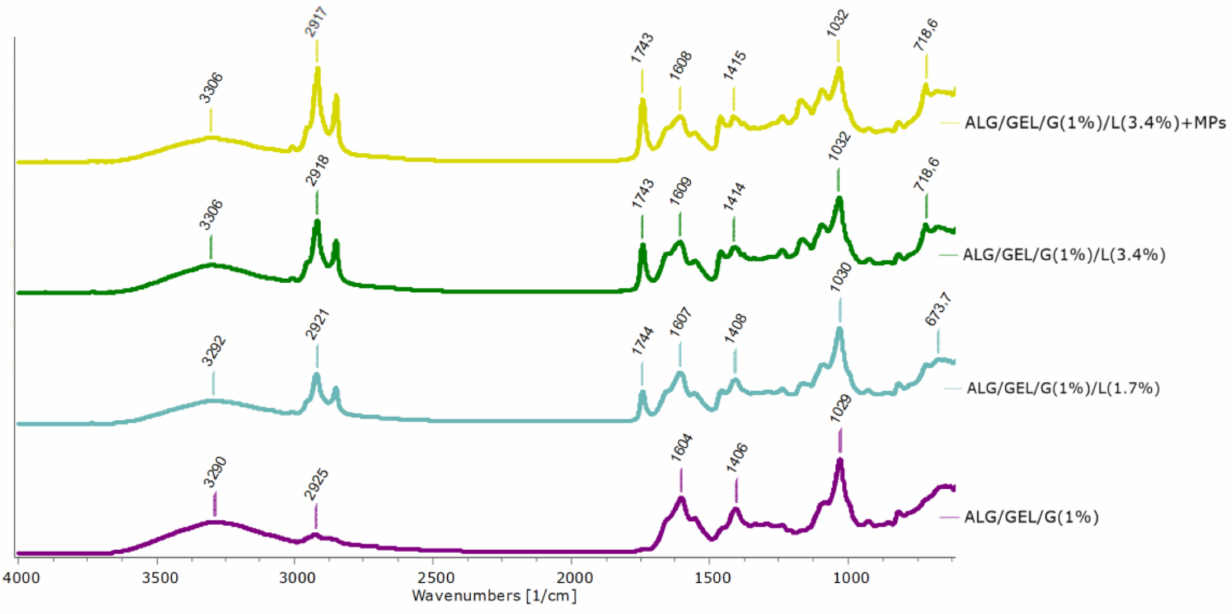
Figure 4. ATR-FTIR spectra of non-cross-linked materials based on sodium alginate, gelatin and 1% of glycerin, as well as with lipids (cottonseed oil and beeswax) and PLA